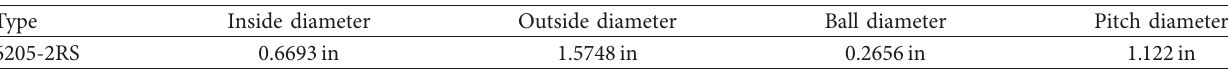
Table 10: Parameters of the